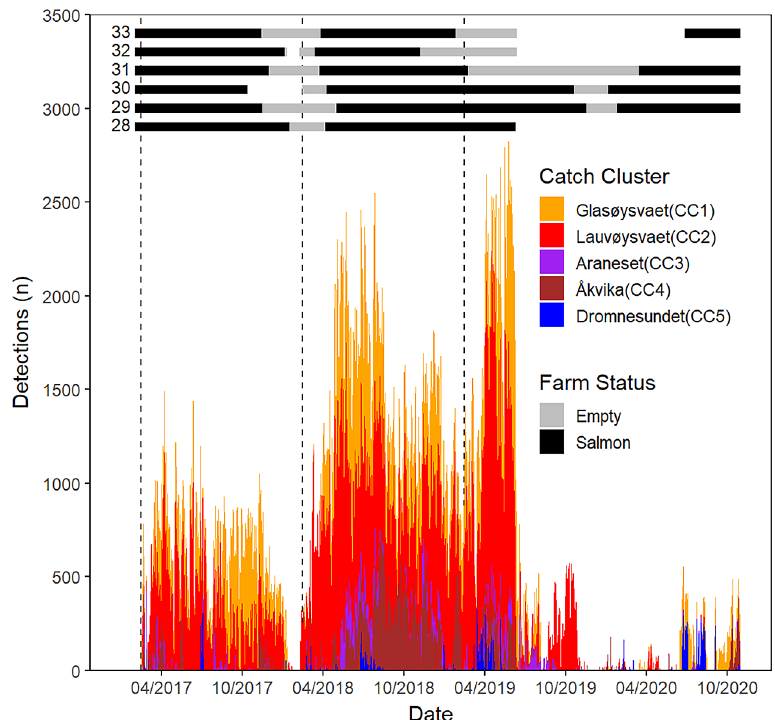
Fig. 3. Number of daily detections of cod across all salmon farms during the study. Colours represent catch clusters. Vertical dotted lines: yearly release